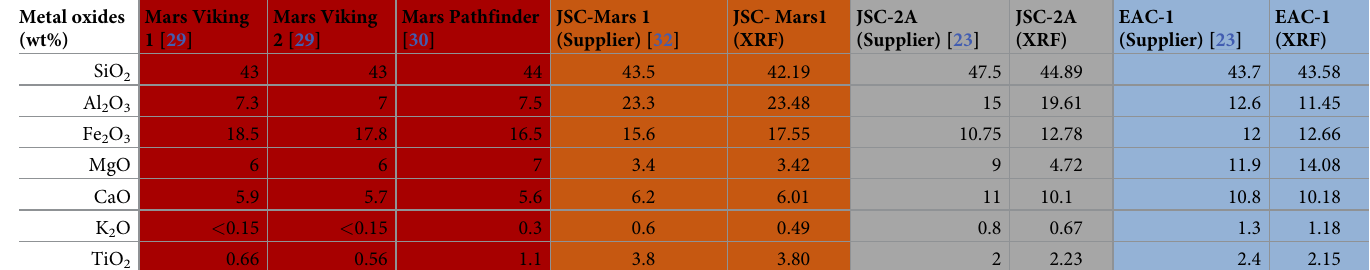
Table 2. Average major metal oxide composition (wt%) at different Mars locations [29–31]and the composition of three different regolith simulant types obtained via X-ray fluorescence (XRF) as well as reported by the suppliers (JSC-Mars1 [32], JSC-2 [23], EAC-1 [23]). Metal oxides Mars Viking Mars Viking (wt%) 1 [29] 2 [29]